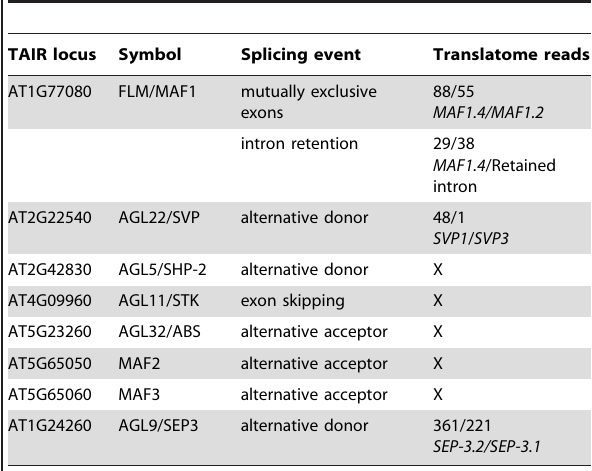
Table 3. Additional translatome evidence for the predicted functional AS